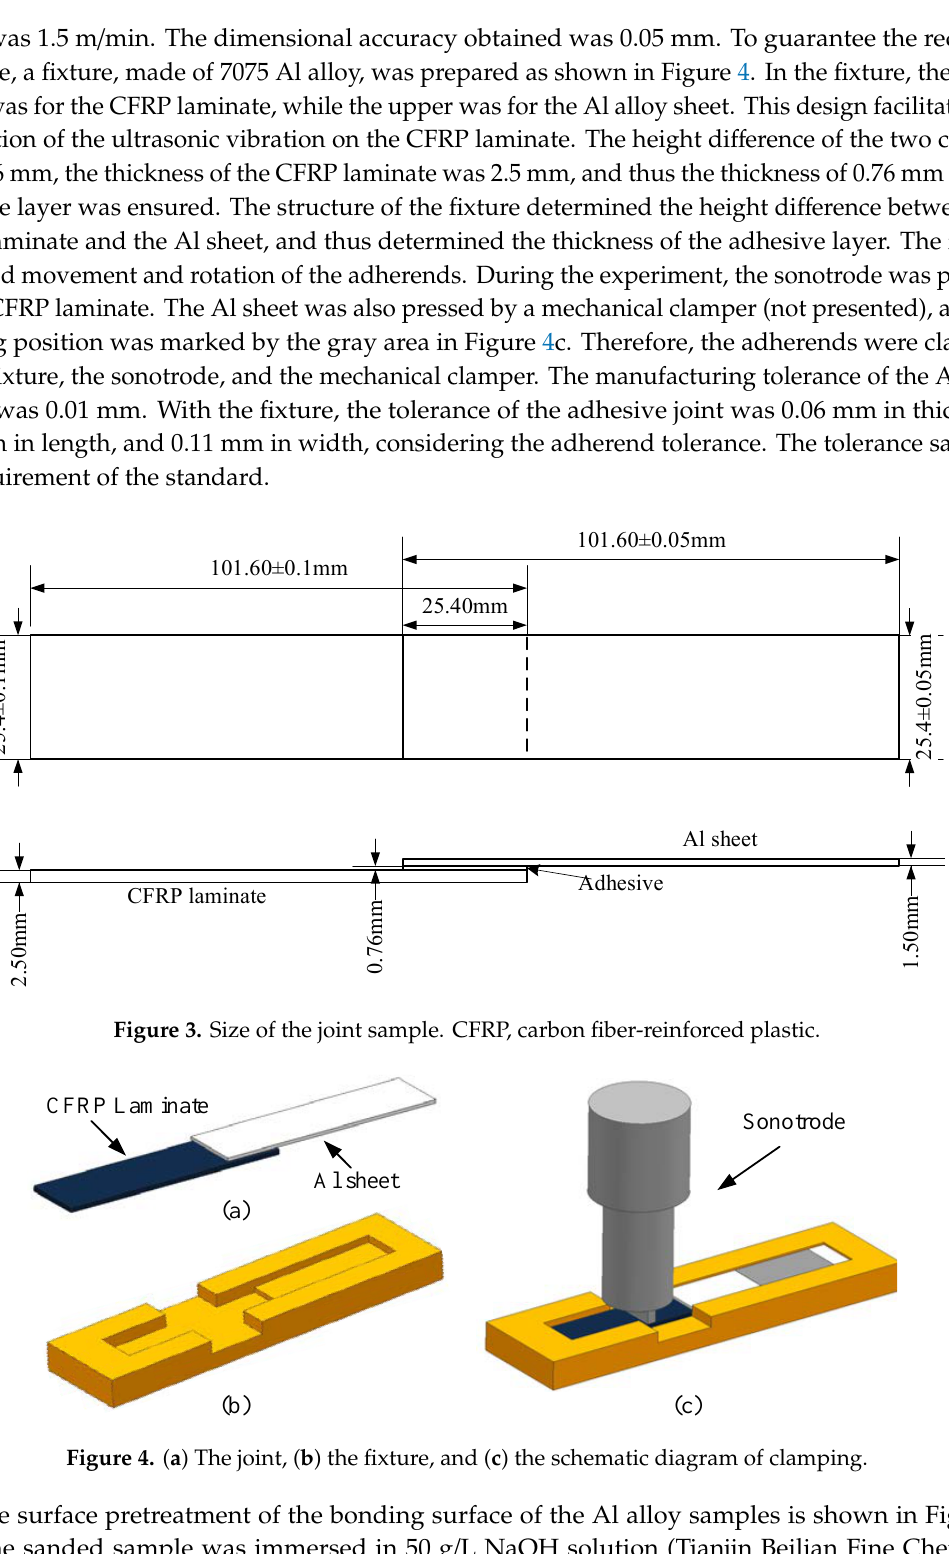
Figure 4. ( a ) The joint, ( b ) the fixture, and ( c ) the schematic diagram of clamping.